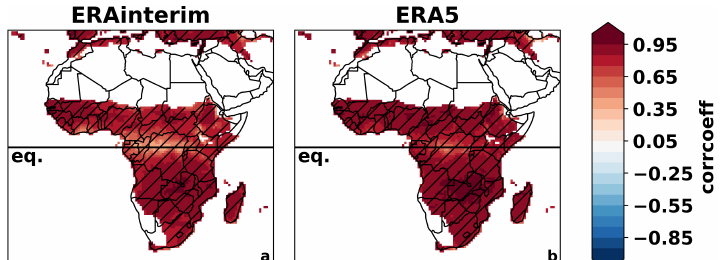
Figure 5. Observed precipitation (CHIRPS) averaged over 1981–2017 ( a ) and difference between ERA-interim ( b )/ERA5 ( c ) precipitation averaged over 1981–2017 and CHIRPS precipitation averaged over 1981–2017. Hatching represents regions where differences are statistically significant at the 1% level.